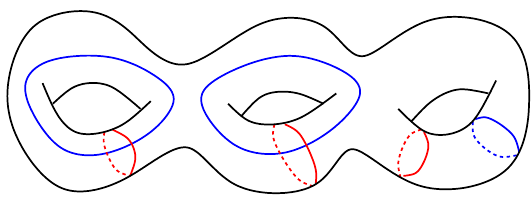
Figure 3 . The standard genus- g Heegaard diagram for # k ( S 1 (cid:2) S 2 ), with g = 3 and k = 1. (cid:24) = \ g ( S 1 (cid:2) B 2 ) is rather simple, 1 the power of the While each handlebody M ( i ) 3